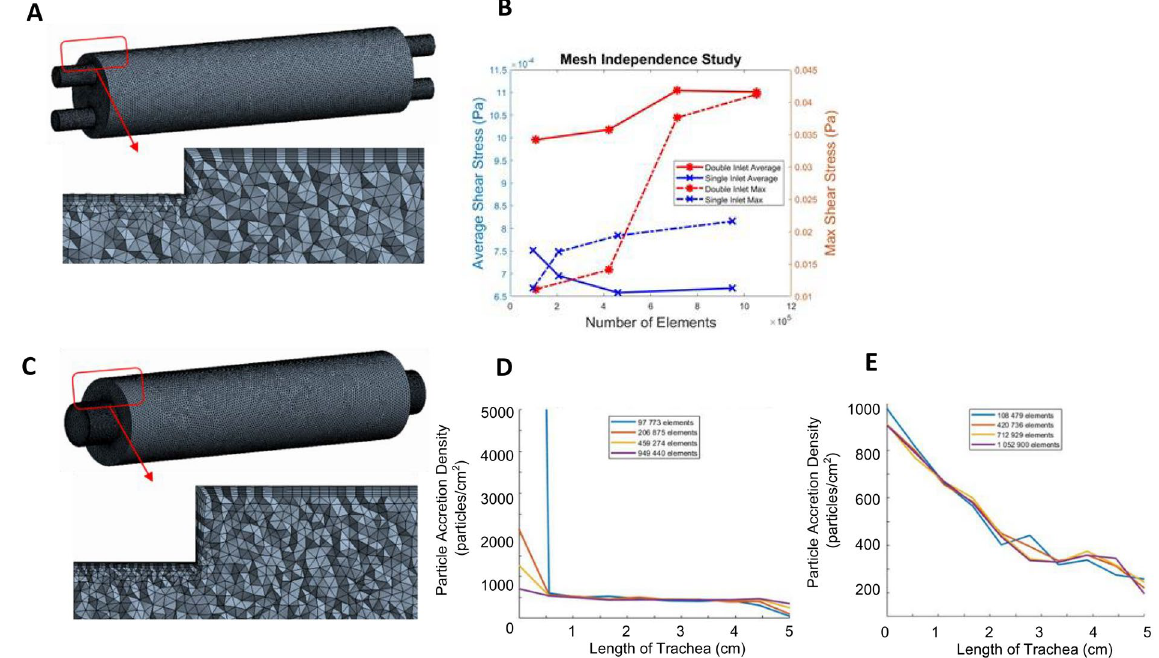
Figure 7. Finalized mesh of the bioreactor inner chamber. ( A ) Double static inlet bioreactor design meshed geometry and its magnified cross sectional view of the mesh highlights the inflation layers near the boundaries; ( B ) Mesh independence study plot of the average lumen wall shear stress at 15 rpm of rotational velocity for the double inlet (blue) and single inlet design (red); ( C ) Single rotating inlet bioreactor design meshed geometry and its magnified cross-sectional view; Mesh independence plot showing spatial uniformity of particle accretion at the finalized mesh for the ( D ) single and ( E ) double inlet designs. ( A ) and ( C ) were generated using